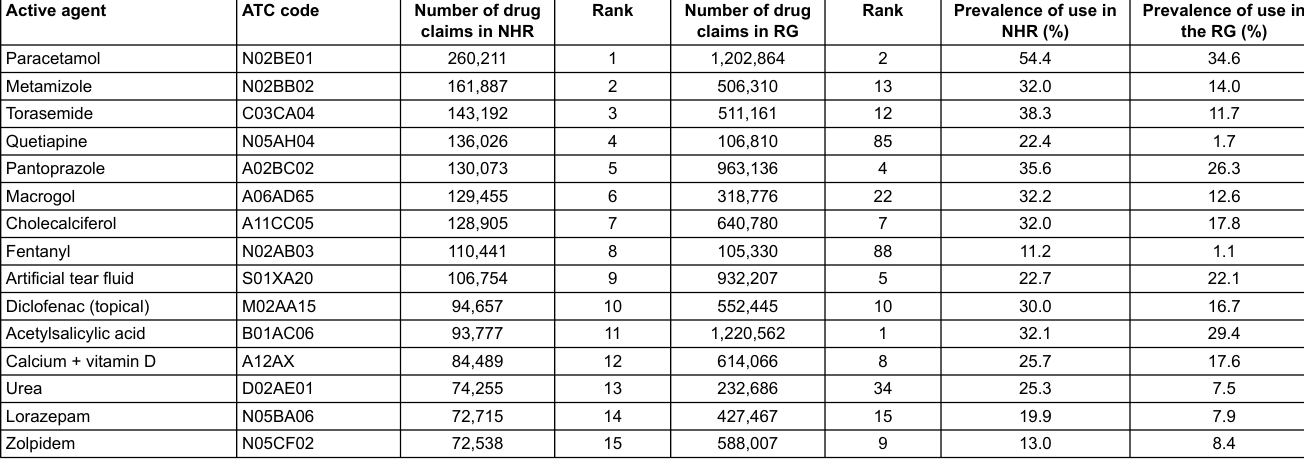
Table 3: The 15 most frequent drugs in NHR compared with the RG (individuals aged ≥65 years insured with Helsana, excluding NHR) and the prevalence of their use, ranked by number of drug claims, year